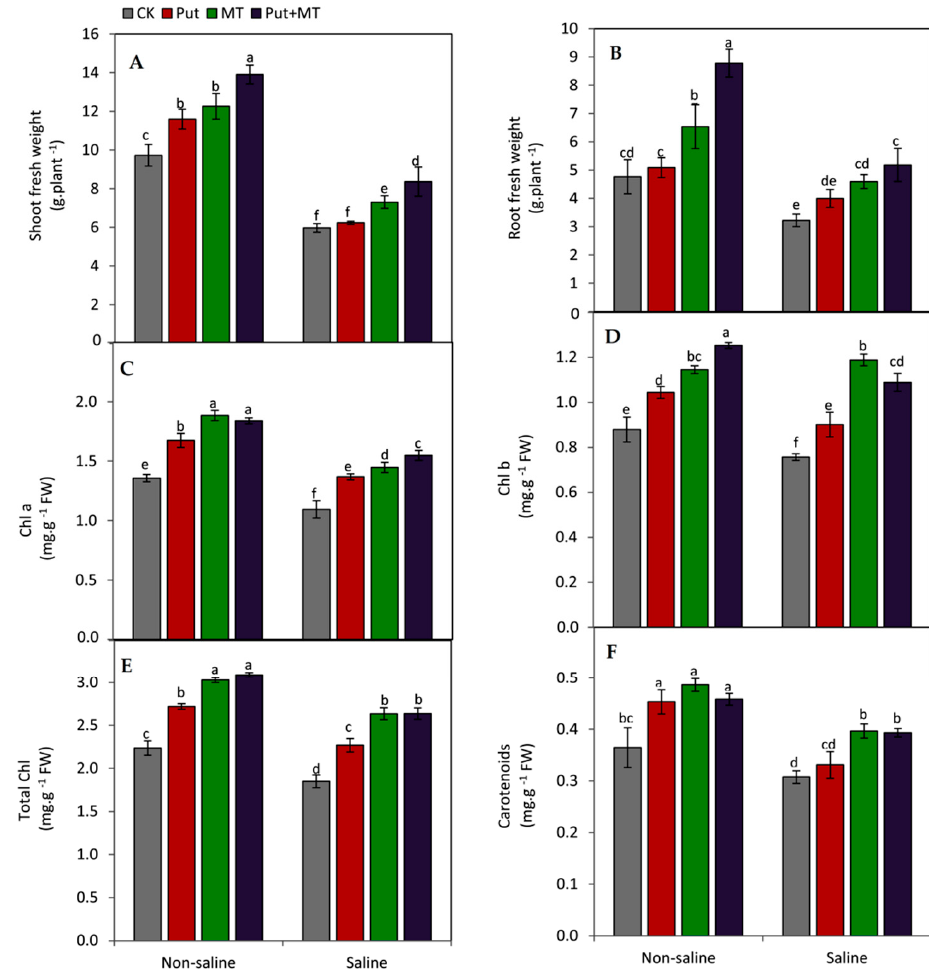
Figure 1. Effect of melatonin (MT; 20 µ M), putrescine (Put; 100 µ M), and their combination on the growth and leaf pigments of snap bean seedlings grown under control and salt stress (50 mM NaCl). ( A ) Shoot fresh weight, ( B ) shoot dry weight, ( C ) chlorophyll a , ( D ) chlorophyll b , ( E ) total chlorophyll, and ( F ) carotenoids. The upper error bar denotes standard deviation, while various lowercase letters above the bars denote significant differences according to Duncan’s multiple range tests ( p ≤ 0.05).